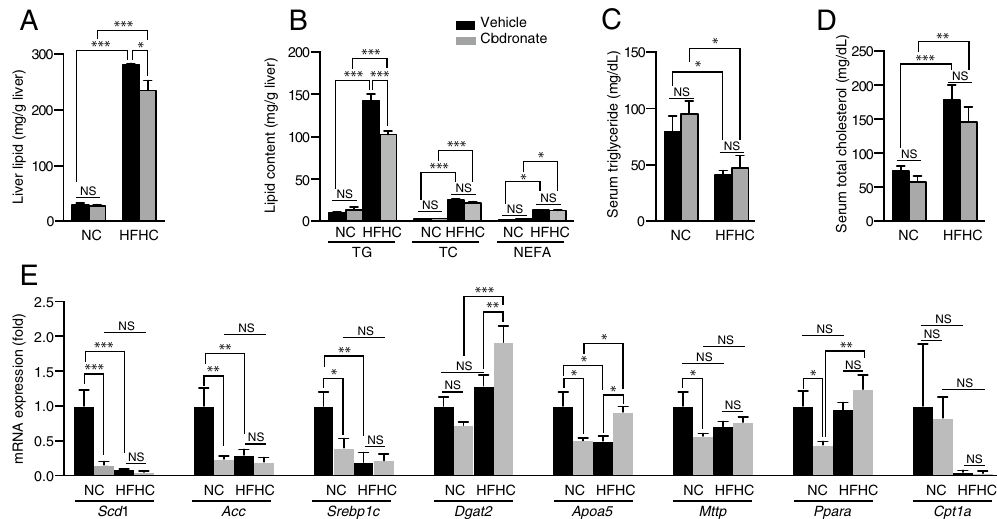
Figure 4. Clodronate suppresses triglyceride accumulation and de novo fatty acid synthesis-related gene expression in the liver. The lipid metabolism of mice treated as described in Fig. 3 was investigated (n = 5 per treatment group). ( A ) The total hepatic lipid content was determined using Folch’s method. ( B ) The hepatic levels of triglycerides (TG), total cholesterol (TC), and nonesterified fatty acids (NEFA) were assessed with enzymatic assays. ( C ) The serum triglyceride and ( D ) TC levels were quantified using biochemical assays. ( E ) The mRNA levels of genes associated with lipid metabolism in the livers of normal chow (NC) diet-fed mice and high-fat, high-cholesterol (HFHC) diet-fed mice were determined by quantitative real-time PCR. Gene expression is shown as the fold change relative to the vehicle-treated group fed the NC diet. All data are shown as the mean ± SEM. * P < 0.05, ** P < 0.01, *** P < 0.001. NS not